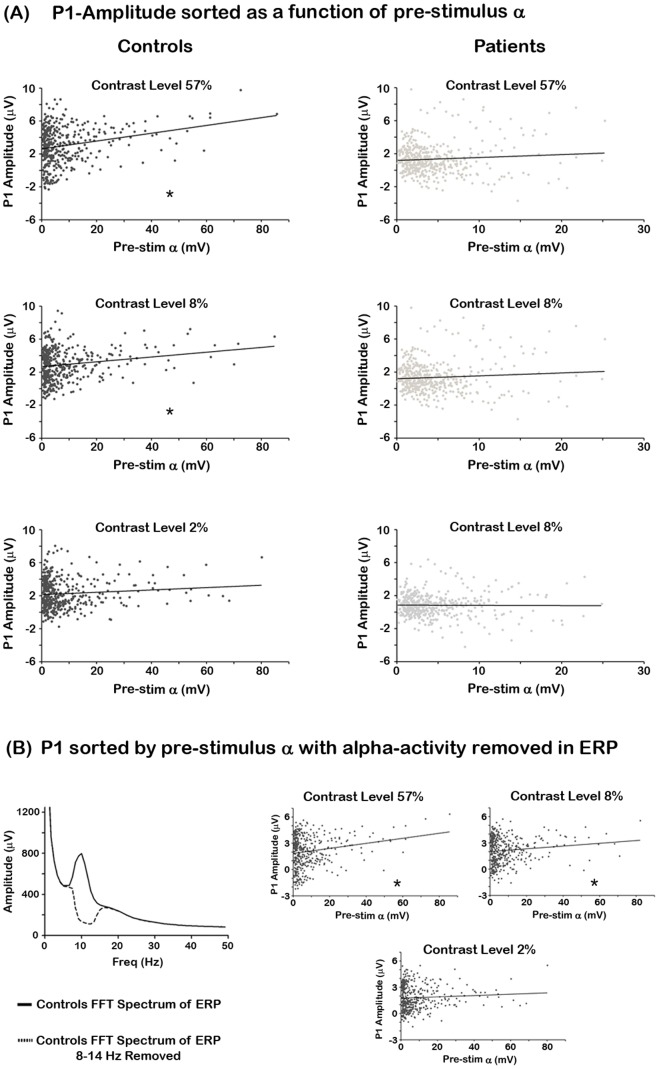
Relationship between the P1 amplitude and pre-stimulus alpha.(A) Amplitude values of the P1 ERP component plotted as a function of binned pre-stimulus alpha amplitude on a single trial level. (B) This figure shows the relationship between the P1 amplitude and pre-stimulus alpha after removing post-stimulus alpha-band activity. The graph on the left shows the FFT spectrum of the ERP with alpha-band activity (solid lines) and without alpha (dashed lines). The three graphs on the right show amplitudes of the P1 component plotted as a function of pre-stimulus alpha power after 8–14 Hz activity was removed.